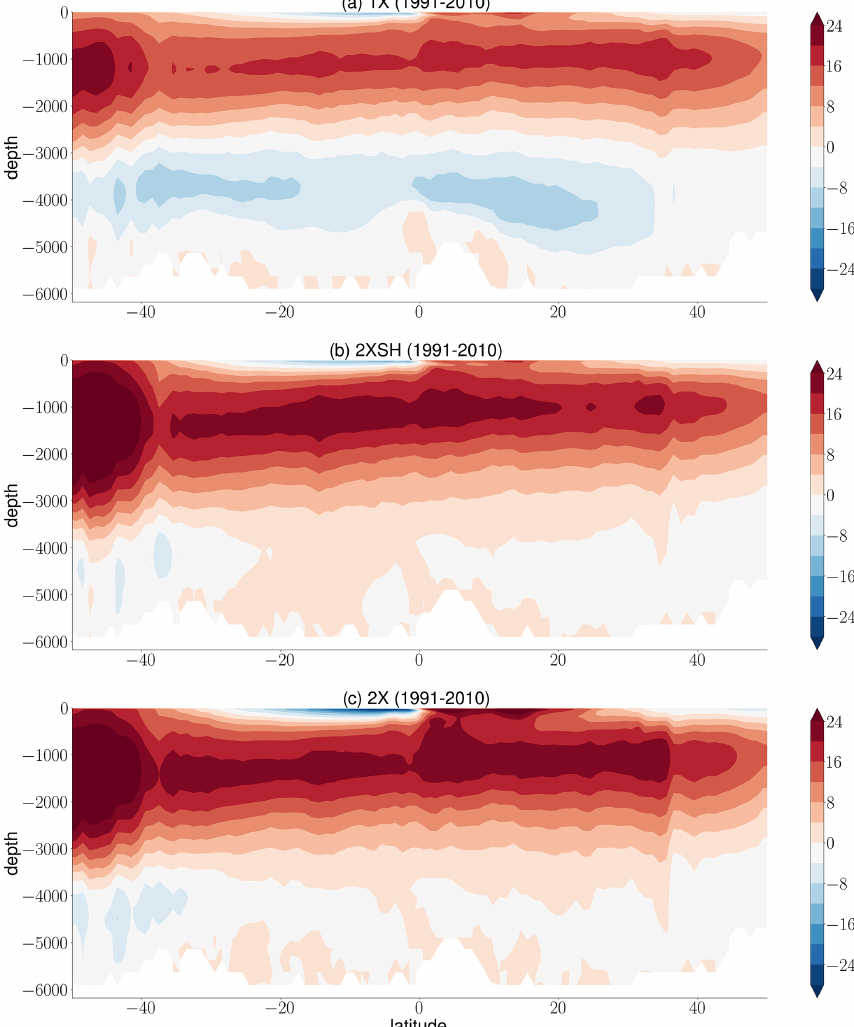
Figure 2. The time-mean AMOC streamfunctions (1991–2010) in the (a) 1X experiment, (b) 2XSH experiment, and (c) 2X